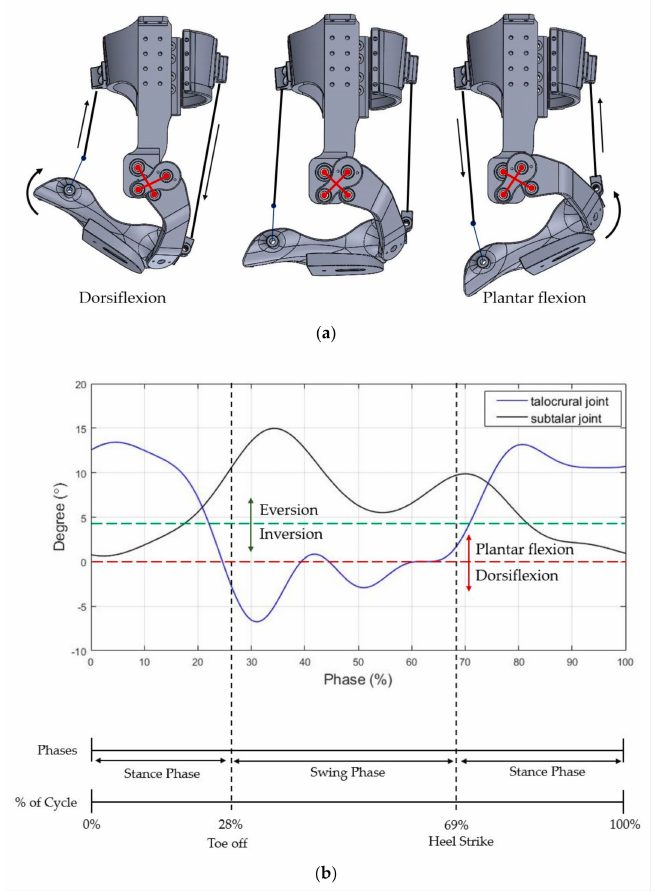
Figure 3. Ankle structure movement and gait data: ( a ) polycentric structure movement according to the movement of both cables; ( b ) the encoder date of the ankle joint obtained during the gait. To perform gait training, it is necessary to understand the gait cycle and gait